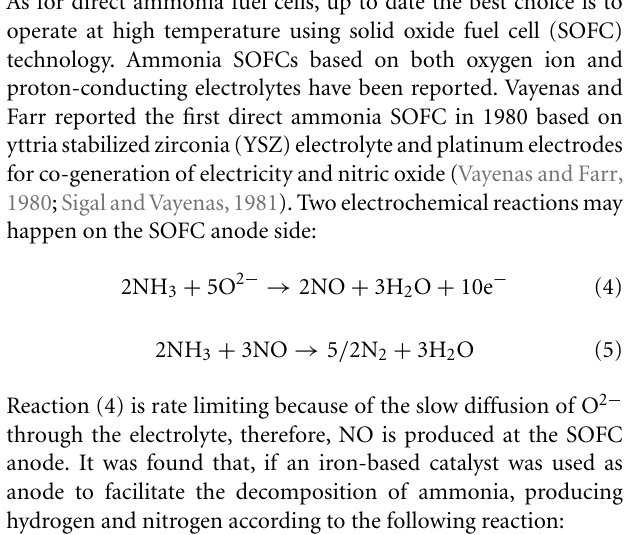
generation (Boggs and Botte, 2009). Besides proton